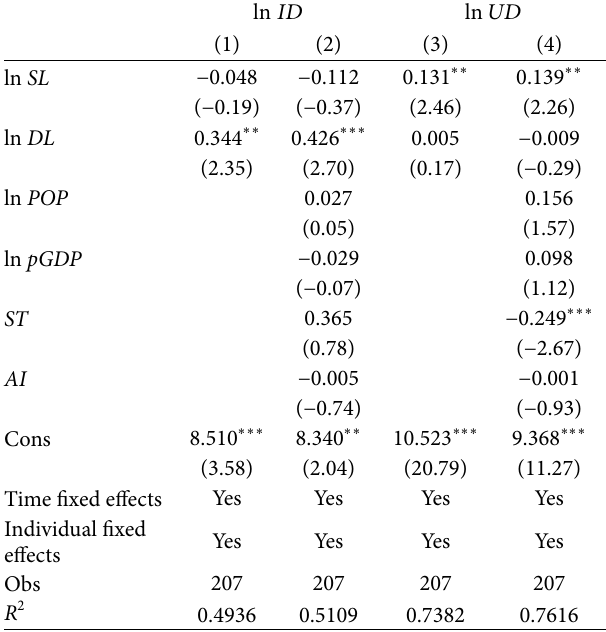
Table 7: Inspection of water pipeline